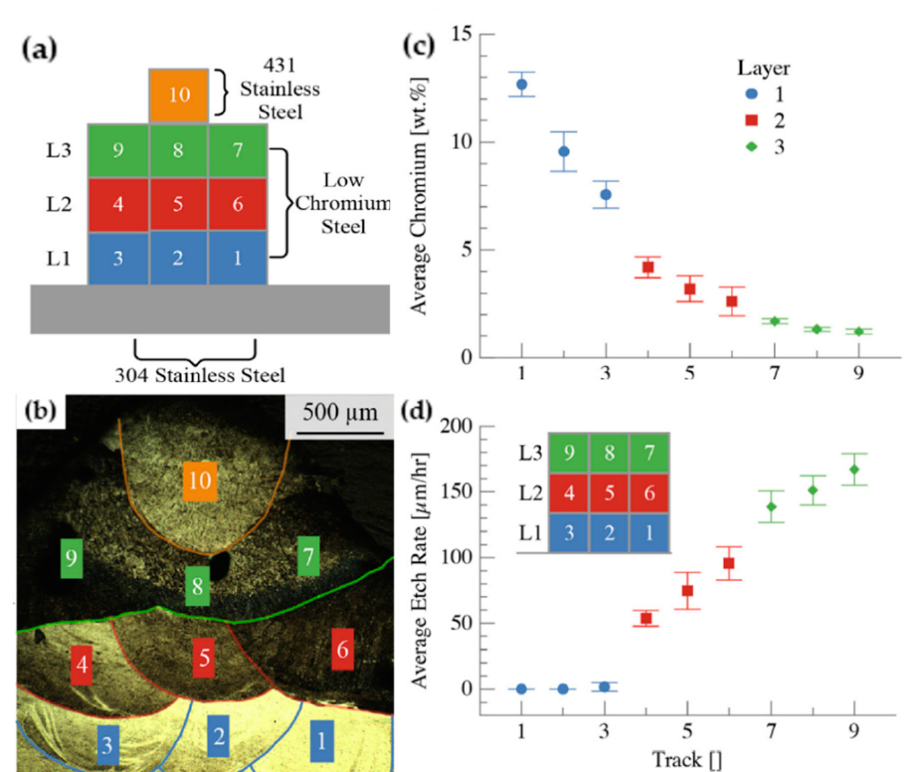
Figure 9. ( a ) Schematic diagram; ( b ) SEM image of the FGMs fabricated by DLD; ( c ) their Cr content; ( d ) the etch rate